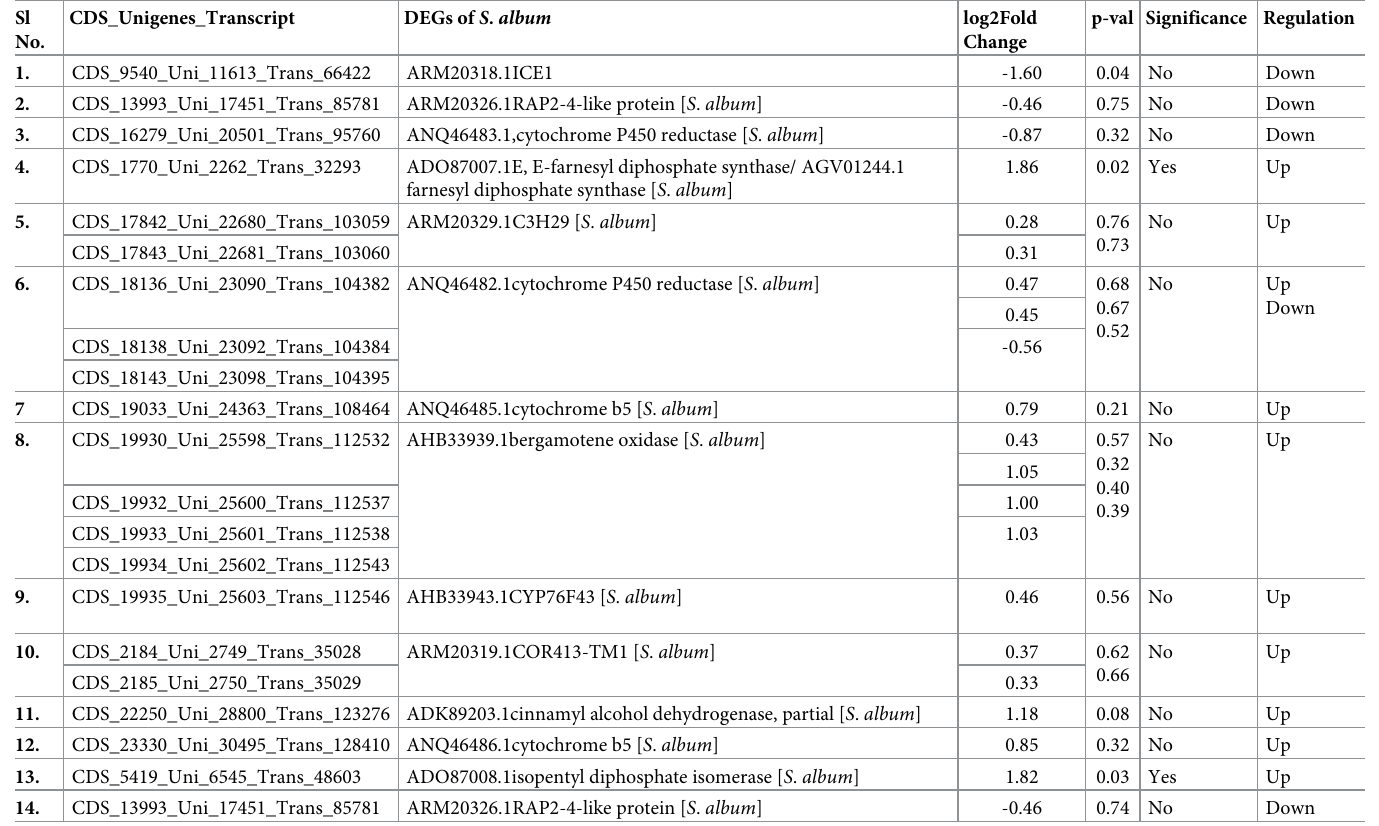
Table 7. List of DEGS commonly expressed in sandalwood ( S . album ). Sl CDS_Unigenes_Transcript DEGs of S . No.